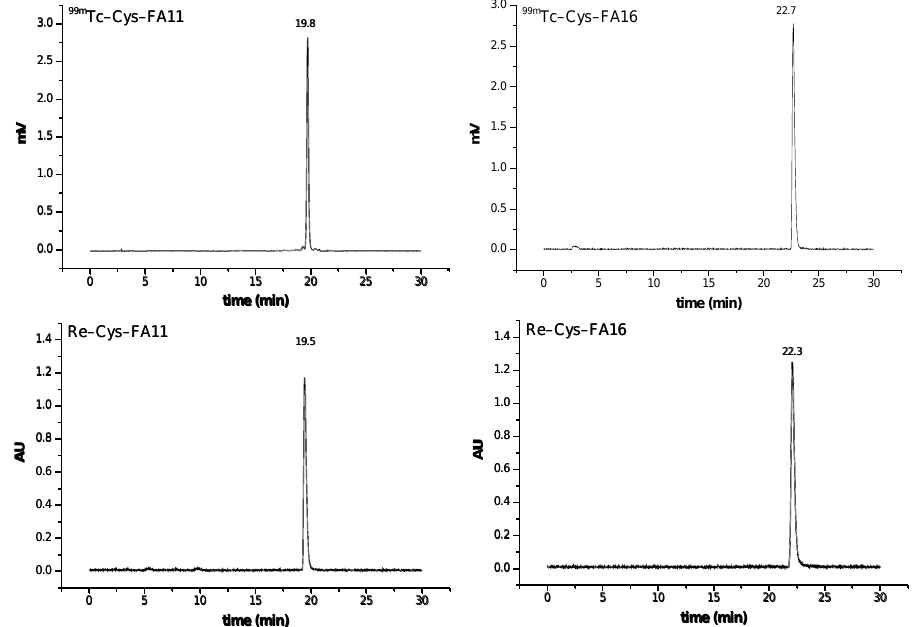
Figure 1. Representative HPLC chromatograms of complexes: 99m Tc–Cys–FA11 and 99m Tc–Cys–FA16 (radiometric detection), Re–Cys–FA11 and Re–Cys–FA16 (UV detection).